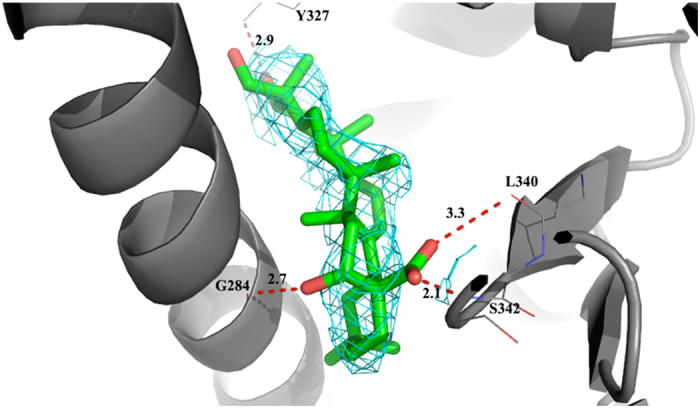
Binding of Sapogenin 19 in the LBD of PPARγ with 2Fo-Fc electron density map calculated around the ligand.